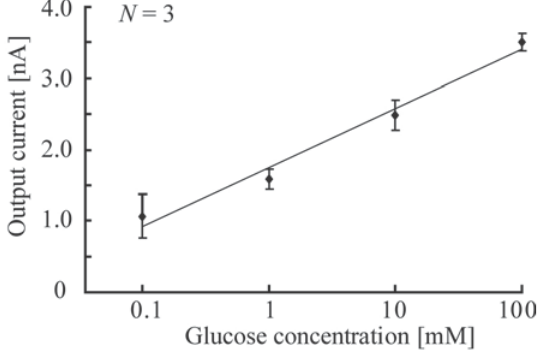
Figure 8. Relationship between glucose concentration and